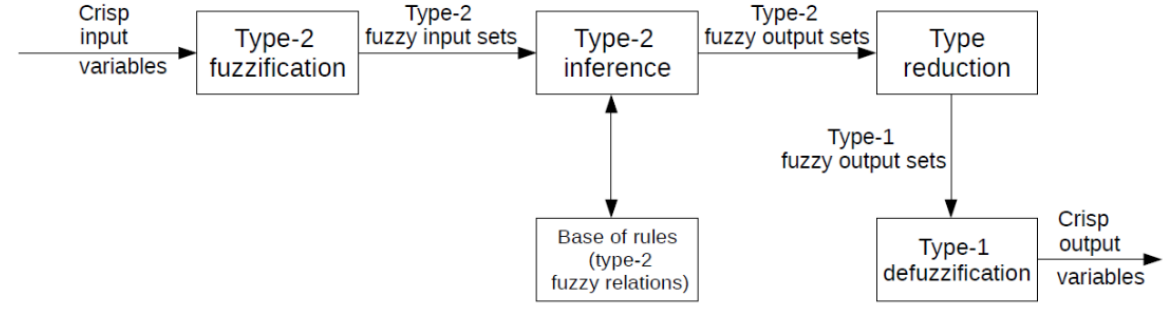
Figure 8. The structure of type-2 fuzzy logic inference system; elaborated based on [56].